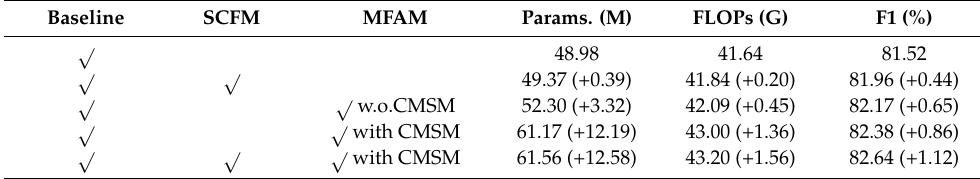
Table 9. Parameters and FLOPs for each module of